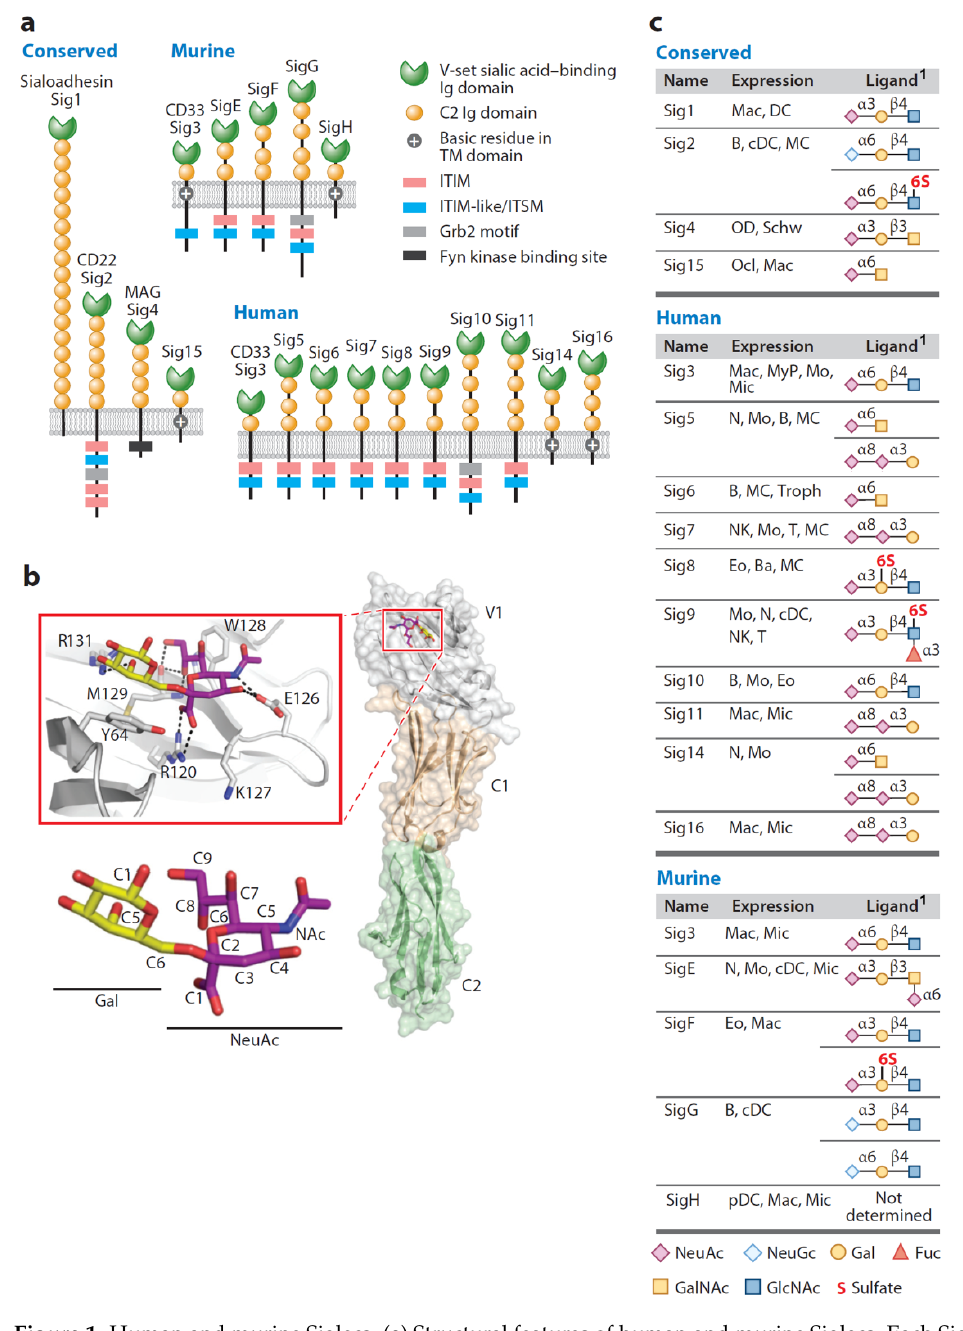
Figure 1. Human and murine Siglecs. ( a ) Structural features of human and murine Siglecs. Each Siglec (Sig) has an N-terminal V-set immunoglobulin (Ig) domain with a conserved sialic acid–binding site, 1-16 additional C2 Ig domains, and a transmembrane domain (TM). Most have intracellular